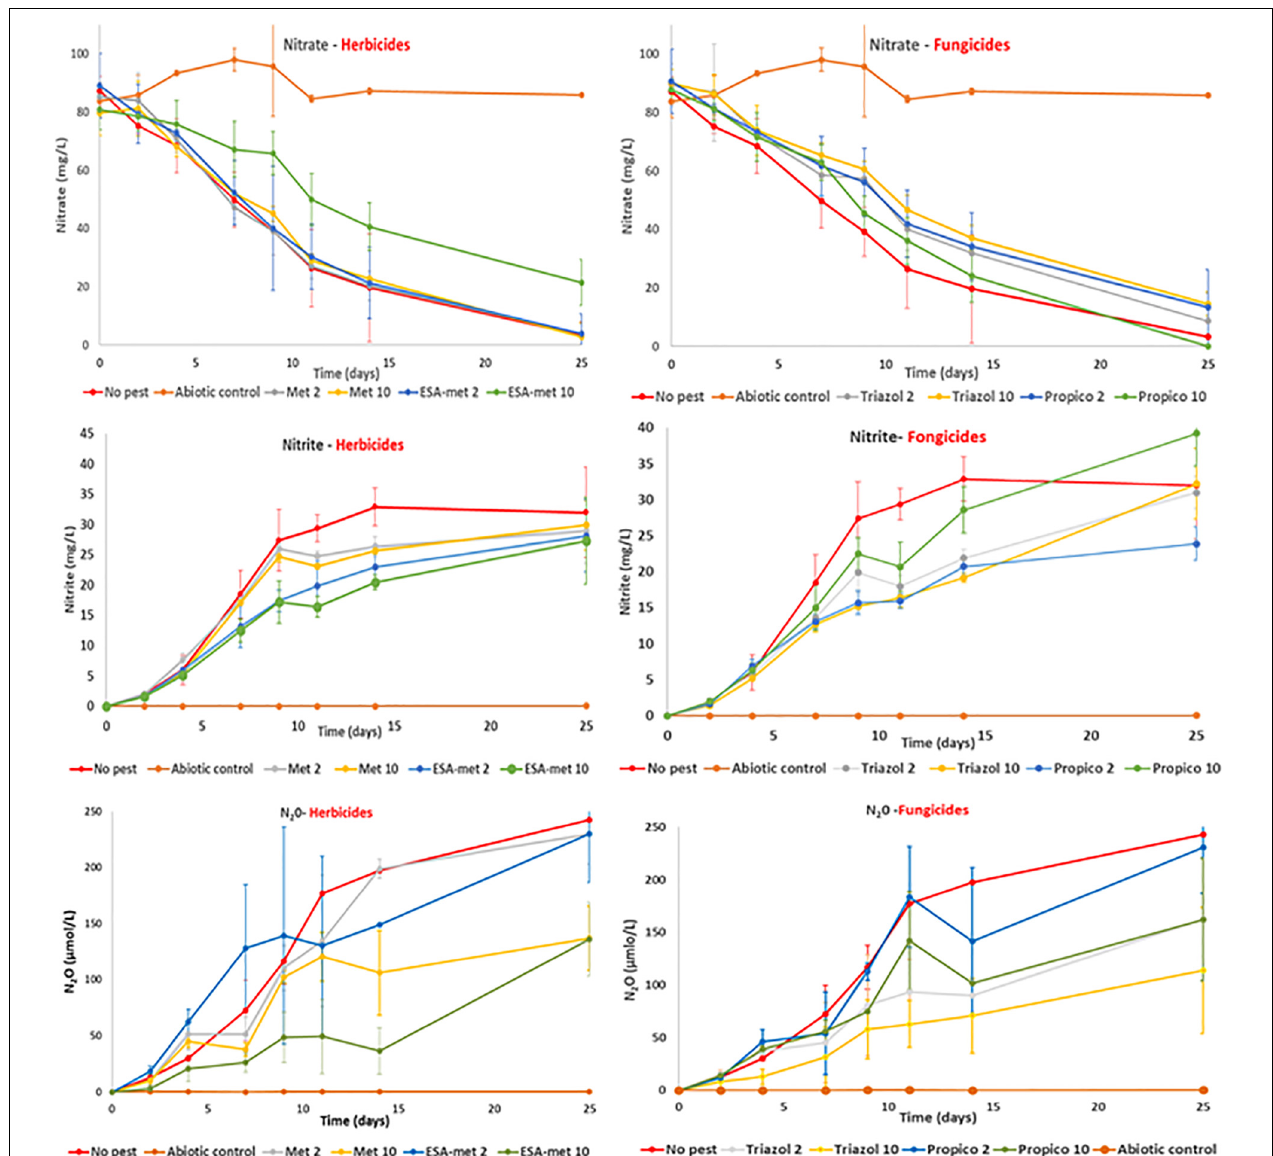
FIGURE 2 | Kinetics of nitrate consumption (top) , nitrite production (middle) , and N 2 0 production (bottom) measured in batch experiments in the absence (no pest) or presence of herbicides [Left: Metolachlor (Met) or its metabolite ESA-metolachlor (ESA-met)] or fungicides [Right: Propiconazole (Propico) or its metabolite 1,2,4-triazole (Triazol)] at 2 or 10 µ g/L. Abiotic control were performed in the presence of azide (cf. “Materials and Methods”